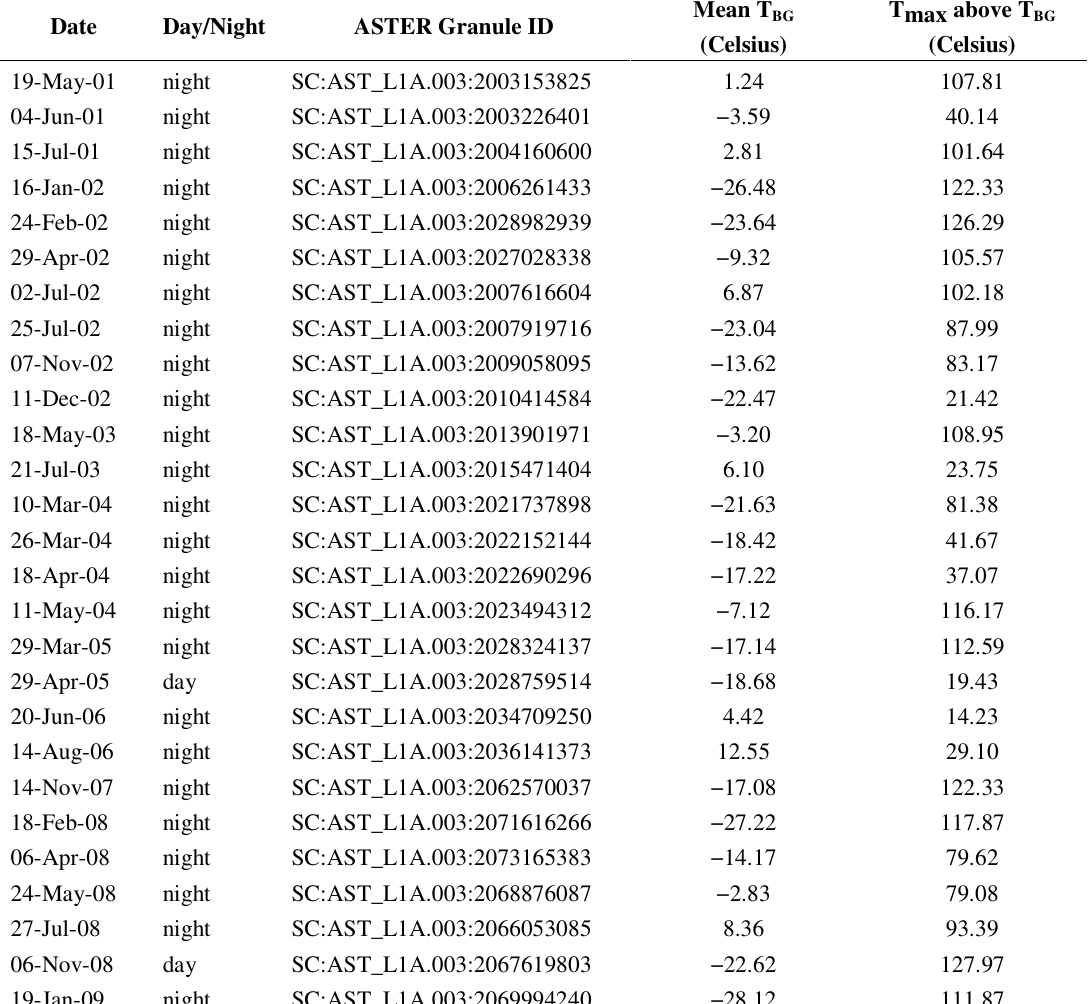
Table 1. ASTER data used within this study. T T = maximum scene max